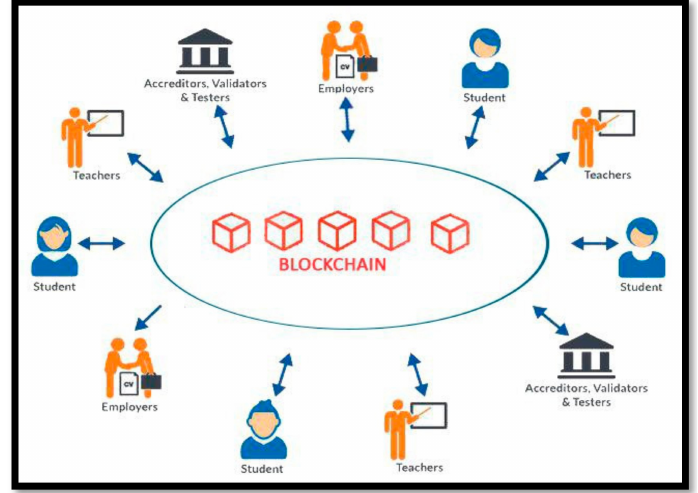
Figure 2. Learner centered blockchain approach.